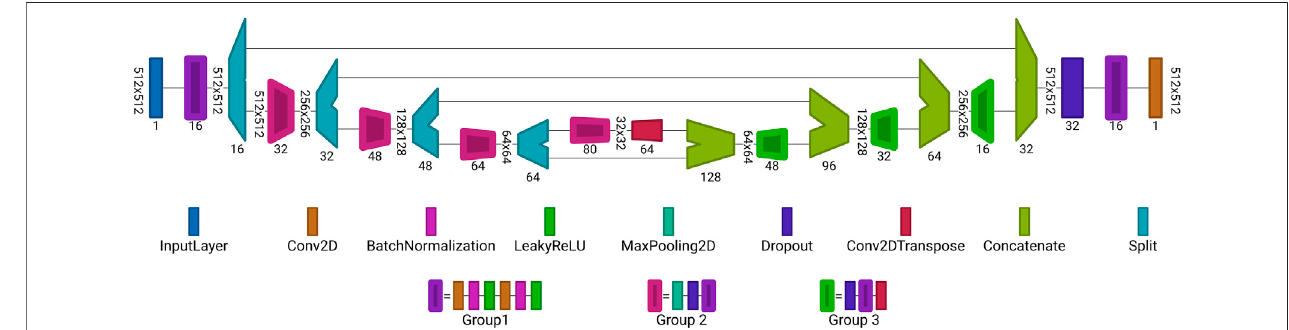
FIGURE 6 | Proposed autoencoder architecture for reconstruction of data from noisy or blurred input. Each block is a set of layers. The values written vertically describe the dimension of the input for each layer, e.g., for noisy and blurred data r (cid:2) 512, c (cid:2) 512 and for the inverse modelling data r (cid:2) 100, c (cid:2) 100. The horizontally written values at the layers are the number of channels or number of fi lters. Group 1 is an combination of layers, consisting of: Conv2D, BatchNormlization, LeakyReLU, Conv2D, BatchNormlization and LeakyReLU layers. Group 2 is an extension of Group 1 where a MaxPooling2D and Dropout layer are placed before Group 1. Similar applies to Group 3, it consists of a Dropout layer followed by the layers from Group 1 and fi nalized by a Conv2DTranspose layer follows. The architecture was visualized with Net2Vis [55].